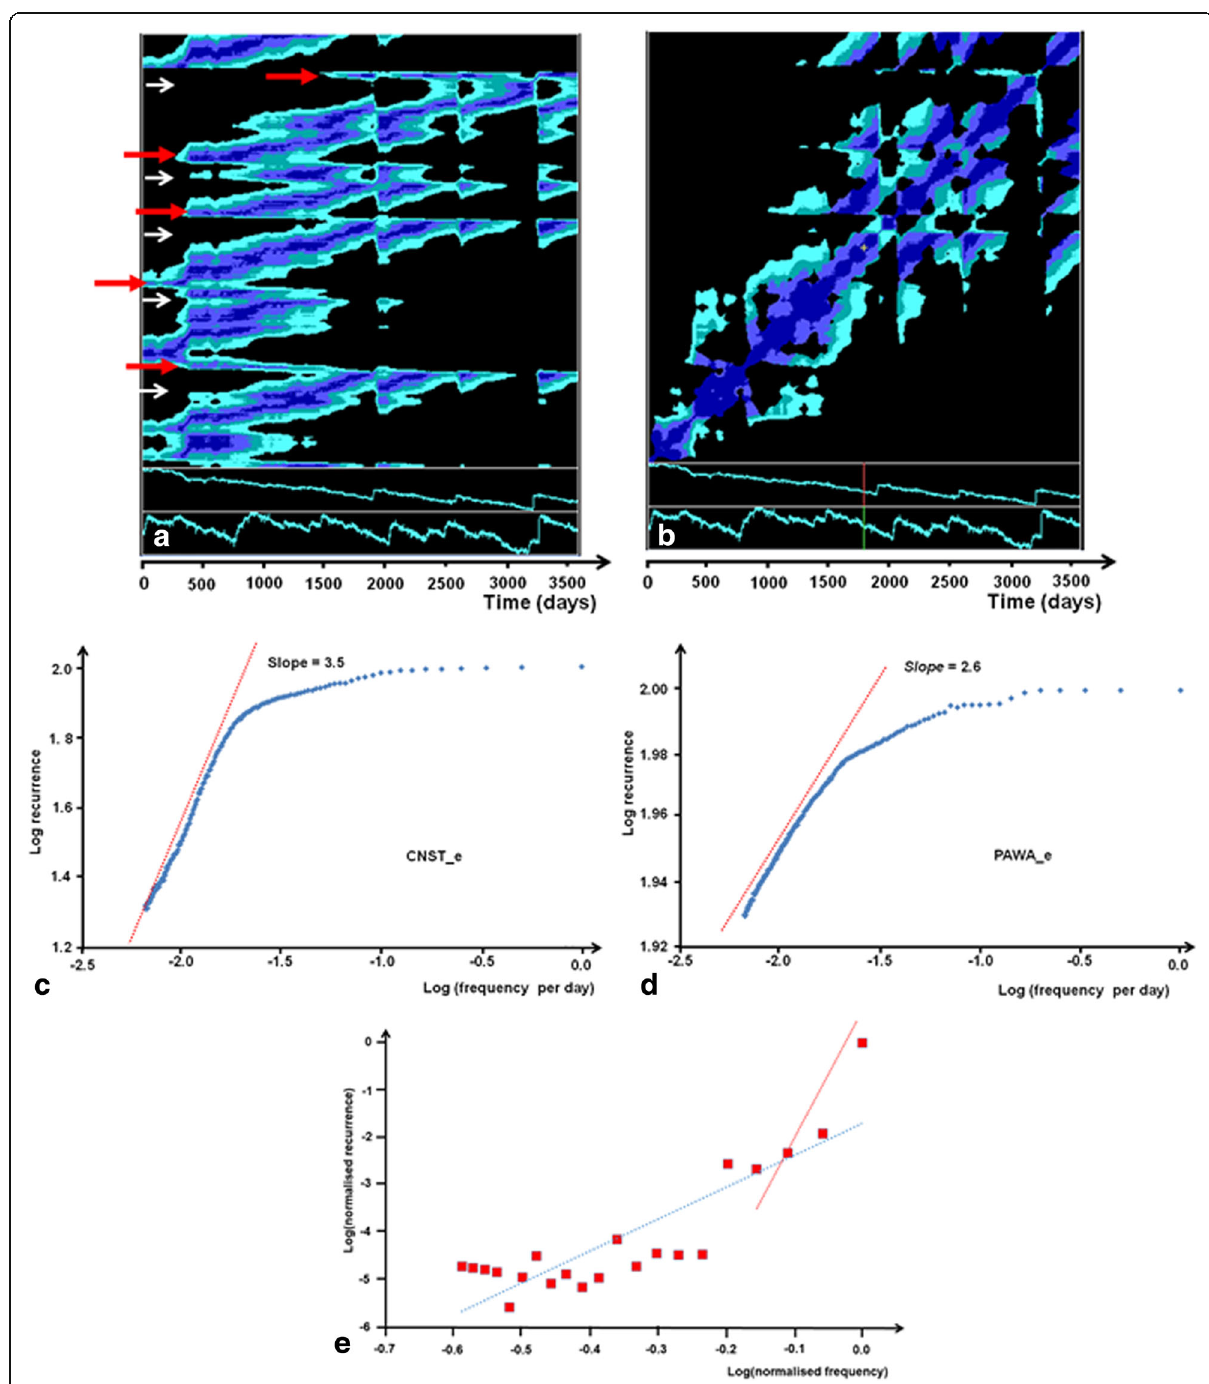
Fig. 18 Synchronisation between stations CNST and PAWA (see Fig. 11a). a Cross recurrence plot between CNST_e (bottom trace) and PAWA_e (top trace). The plot shows lines of synchronisation (LOS) in darkest blue. The red arrows indicate some areas where the ratio of the frequencies of the two signals increases to a large number. The white arrows mark black areas corresponding to no synchronisation. b Joint recurrence plot between CNST_e (bottom trace) and PAWA_e (top trace). The plot shows strong synchronisation of recurrences in the two signals especially along the main diagonal. c , d Plots of log(percent cross recurrences) versus log(1/lag) for CNST_e and PAWA_e respectively. e Logarithm of normalised joint recurrence against logarithm of frequency for CNST_e and